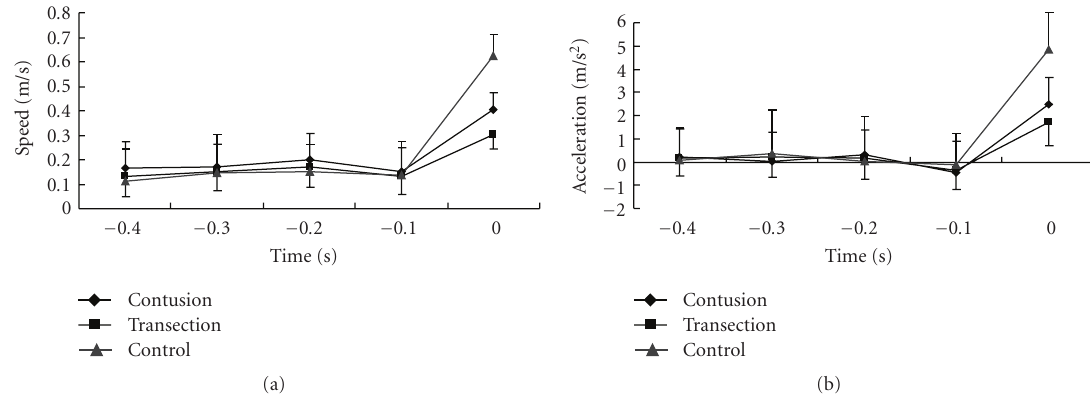
Figure 6: Shifting of the speed and acceleration just before reaching the maximum speed. Time 0 was the moment of maximumspeed. Speed did not gradually increase to the maximum, and mice of all groups showed explosive power in 0.1s to the maximum speed. Interestingly, acceleration 0.1s before the maximum speed was under zero and that suggests muscles that were released just before strong